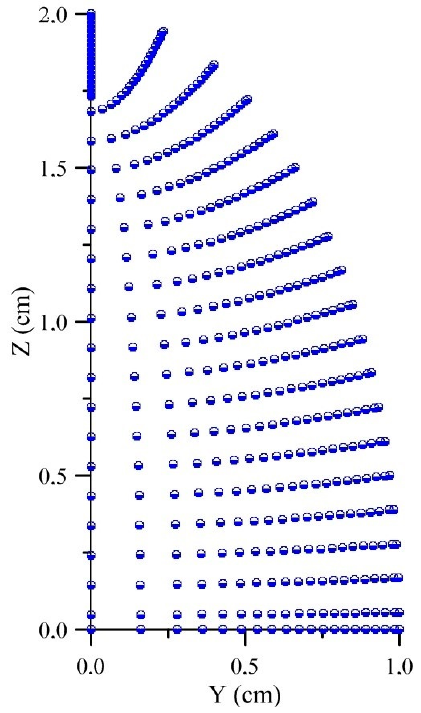
Figure 3. The numerical grid in the physical domain used in the simulations.